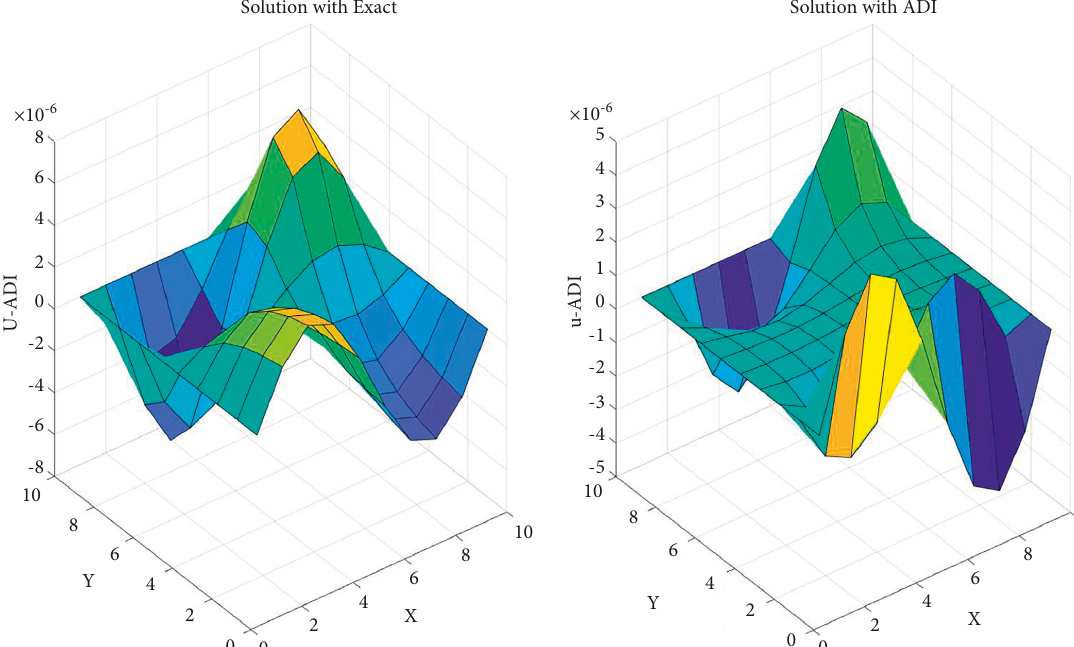
Figure 5: Analytical and approximate results of ADI at 15 × 15 grid size, time � 0 . 5, and time step � 0 .